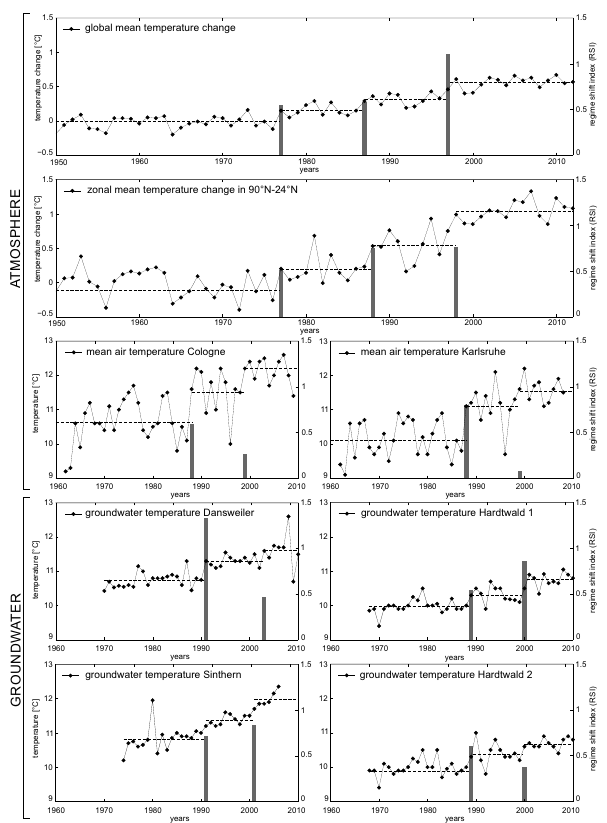
Figure 2. Time series of temperature data with long-term means (dashed lines) and observed regime shifts with calculated RSI val- ues (grey